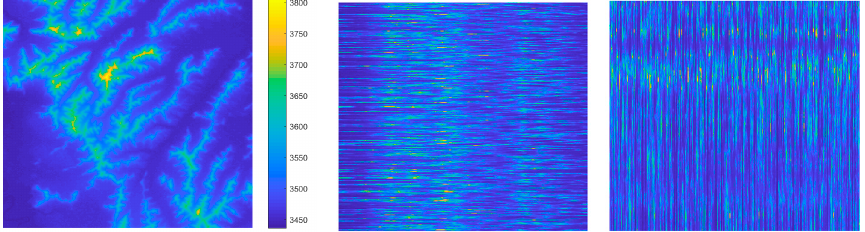
Figure 1. Three digital elevation models (DEMs) with the same histogram and, thus, same Shannon entropy values.